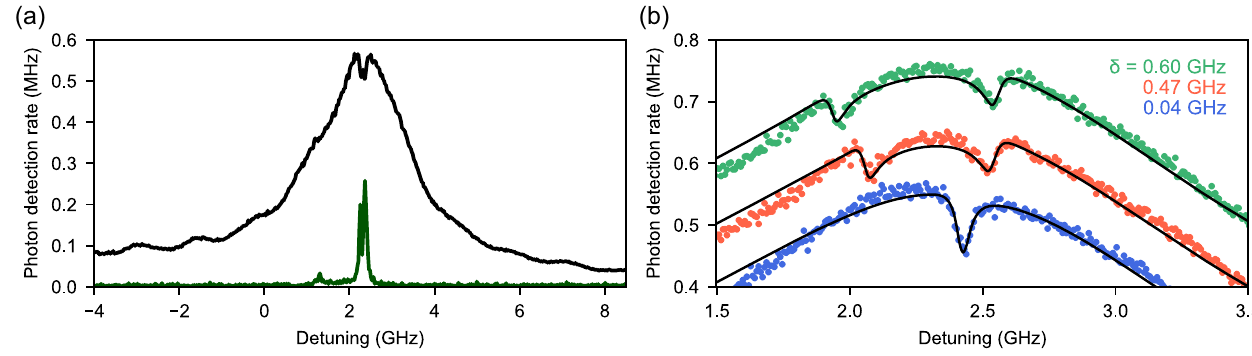
FIG. 2. Dipole-induced transparency (DIT) in SiC. (a) A wide laser scan across the cavity resonance, showing the transmission spectrum through the device (black). The V phonon sideband emission is simultaneously detected (green, multiplied by 50 ×). Si Excitation of the resonator mode is performed through a scattering imperfection on the disk edge and transmission through the waveguide is detected. (b) Close-up scan at the cavity center for different emitter detunings δ . Orange and green traces are offset by þ 0 . 1 and þ 0 . 2 MHz,